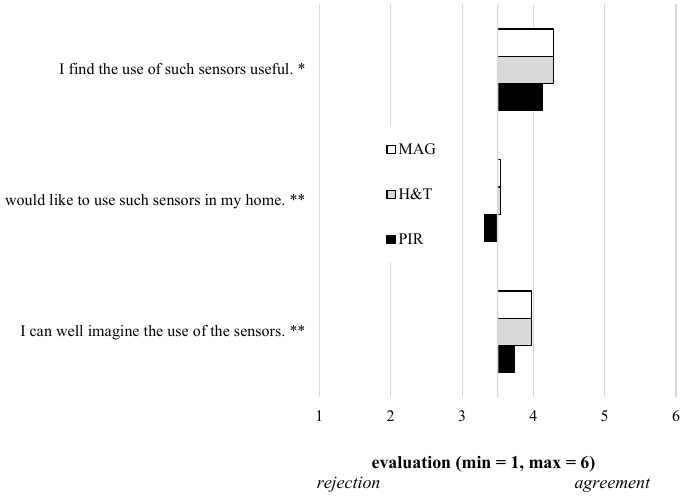
Figure 4. Users’ acceptance of using three different sensor-based lifelogging technologies (RQ3).